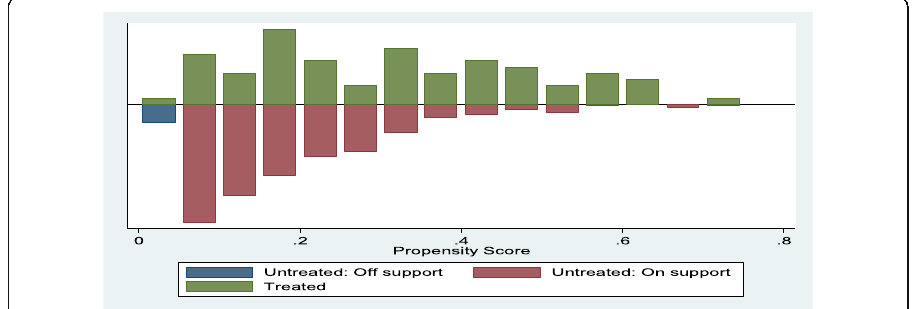
Fig. 1 The distribution of propensity scores for treated and untreated